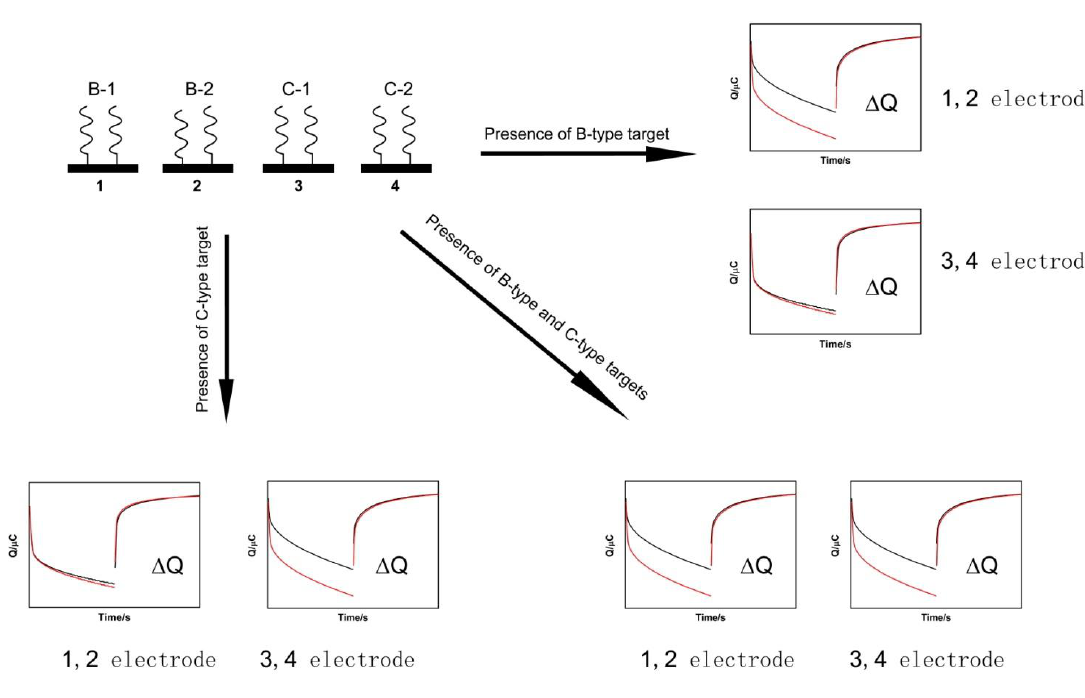
Figure 1. Schematic representation of the chronocoulometric DNA biosensor. B type HBV is determined when the signals of electrodes No. 1 and No. 2 increase simultaneously after hybridization. C type is determined when the signals of electrodes No. 3 and No. 4 increase simultaneously after hybridization. The mixed type is determined when the signals of No. 1, No. 2, No. 3 and No. 4 electrodes increase simultaneously after hybridization. The type cannot be confirmed when the signals of electrodes No. 1 and No. 3 or No. 2 and No. 3 or No. 1 and No. 4 or No. 2 and No. 4 increase simultaneously after